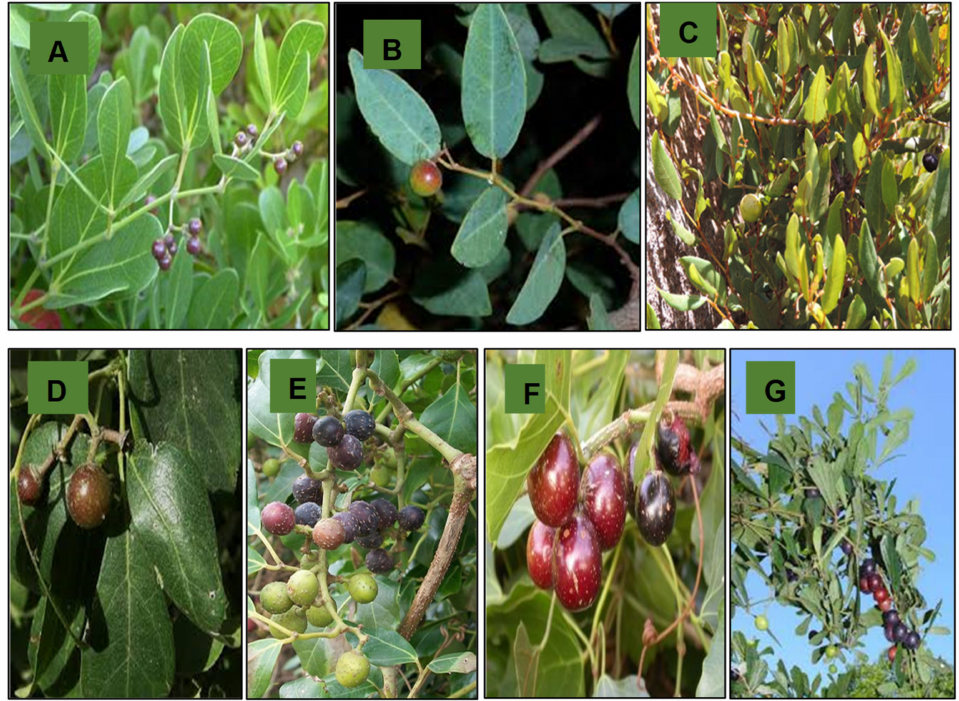
Figure 1. Rhoicissus species: ( A ) R. digitata ; ( B ) R. laetans ; ( C ) R. microphylla ; ( D ) R. revoilii ; ( E ) R. rhom- boidea ; ( F ) R. tomentosa ; ( G ) R. tridentata